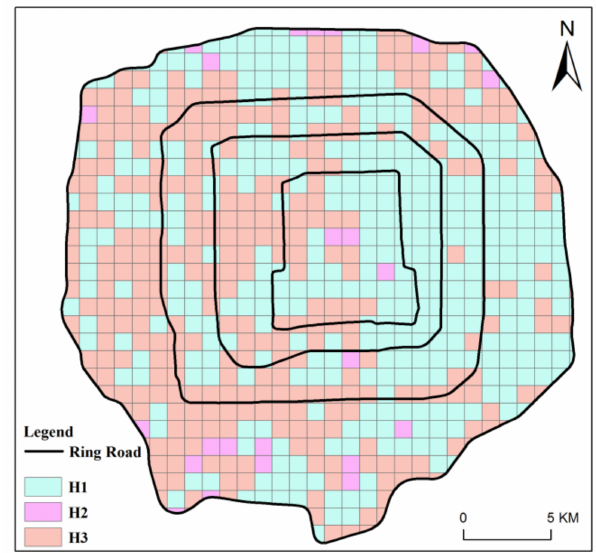
Figure 5. Spatial distribution for three types of functional regions. Using NMF, the 725 1 × 1 km 2 grids were classified into 370 H 1 grids, 23 H 2 grids and 332 H 3